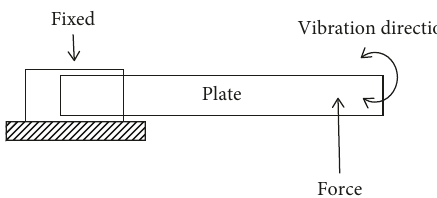
Figure 4: Damping verification plate.